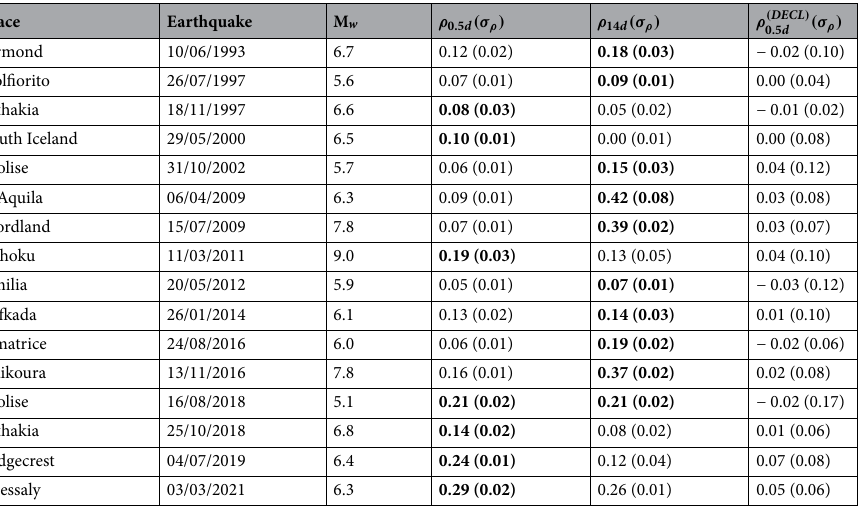
Table 1. Correlation values between tidal (cid:31) CFS and nucleated energy concerning sixteen full-catalog and declustered one-years-long seismic time series in correspondence of moderate and large seismic sequences. The time series starts six months before the mainshock and stops six months later. Only shallow (depth ≤ 50 km) events occurring within the future epicentral area (rectangular regions hit by increased seismic activity during the impending seismic sequence) above the completeness magnitude are considered in this analysis. The fourth column shows our results for full seismic catalogs ( ρ 0.5 d ), while in the fifth one correlations are calculated for simulated tidal stress in which semi-diurnal and diurnal harmonics are removed ( ρ 14 d ). The ( DECL ) last column contains the outputs for Uhrhammer-declustered 42 catalogs ( ρ 0.5 d ). Declustered time series do not provide useful information about tidal triggering of earthquakes, since the correlation values are always compatible with zero. These results strongly suggest that the statistical properties of clustering change as a function of the stability state of crustal volumes. This is obvious after large earthquakes occur, as aftershocks prove, but how earthquake clusters are affected by local spatial and temporal stress patterns is still a puzzle. For the sake of readability, in the present work, except for this table, only results for ρ 0.5 d = ρ time series are